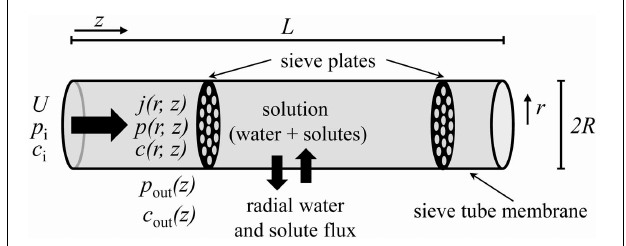
( Figure 1 ). The effect of sieve plates on the overall sieve tube conductance is described by an impedance factor β which is related to sieve tube element structure and given by Thompson and Holbrook (2003a):